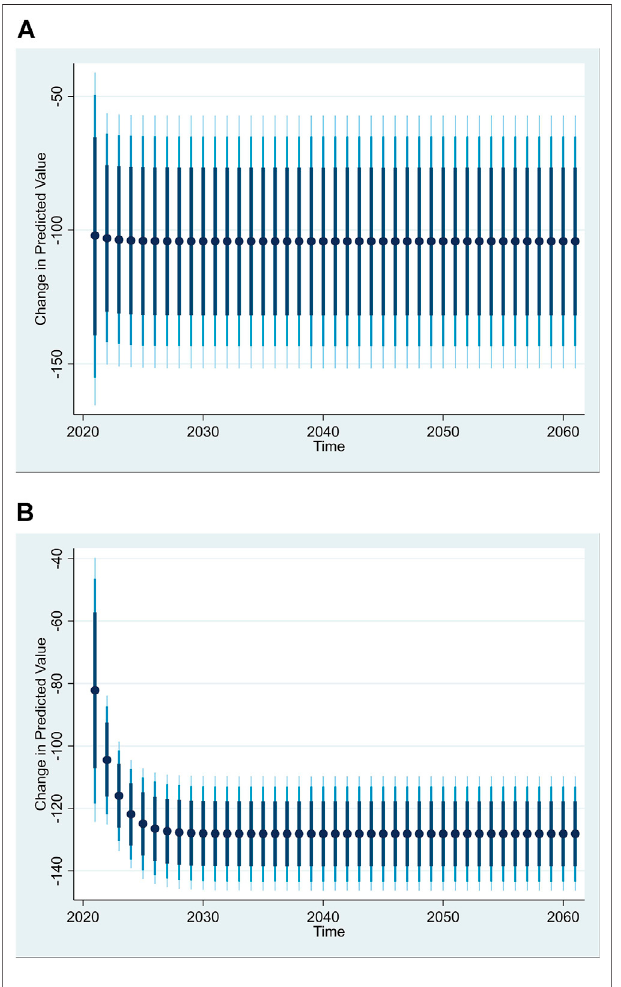
FIGURE6| Representationofcounterfactualshock inforecastvariables employing the DYNARDL model: (A) economic growth: (B) energy (cid:129) ) represent the forecast emissions by consumption. Note: dark navy dot ( − 100% shocks in a log-log model; navy teal, bright blue, and light-blue spikes show 75%, 90%, and 95% con fi dence bands.